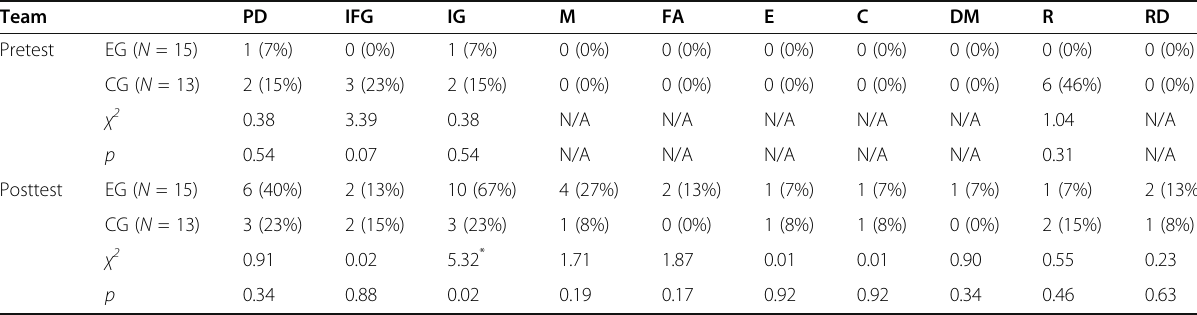
Table 7 Preservice technology teachers ’ performance: explaining system concepts (individual) Team PD